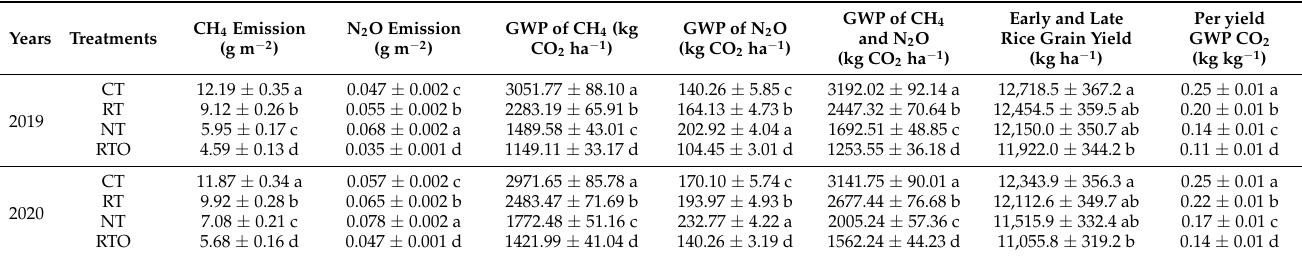
Table 3. GWP of CH 4 and N 2 O emissions from paddy field and per yield GWP with different short-term tillage